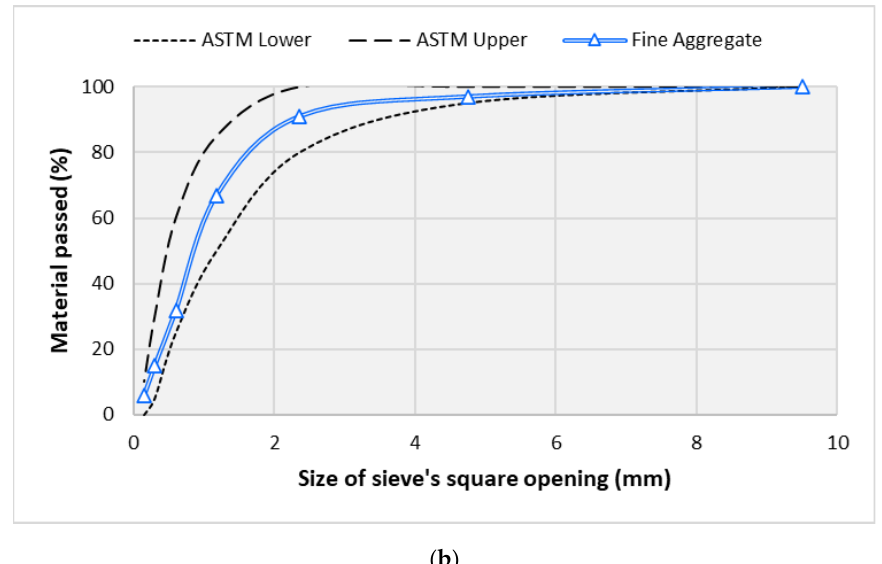
Figure 3. Granulometry of ( a ) coarse aggregates (i.e., NCA and RCA) and ( b ) fine aggregates. Table 2. Aggregates’ properties .